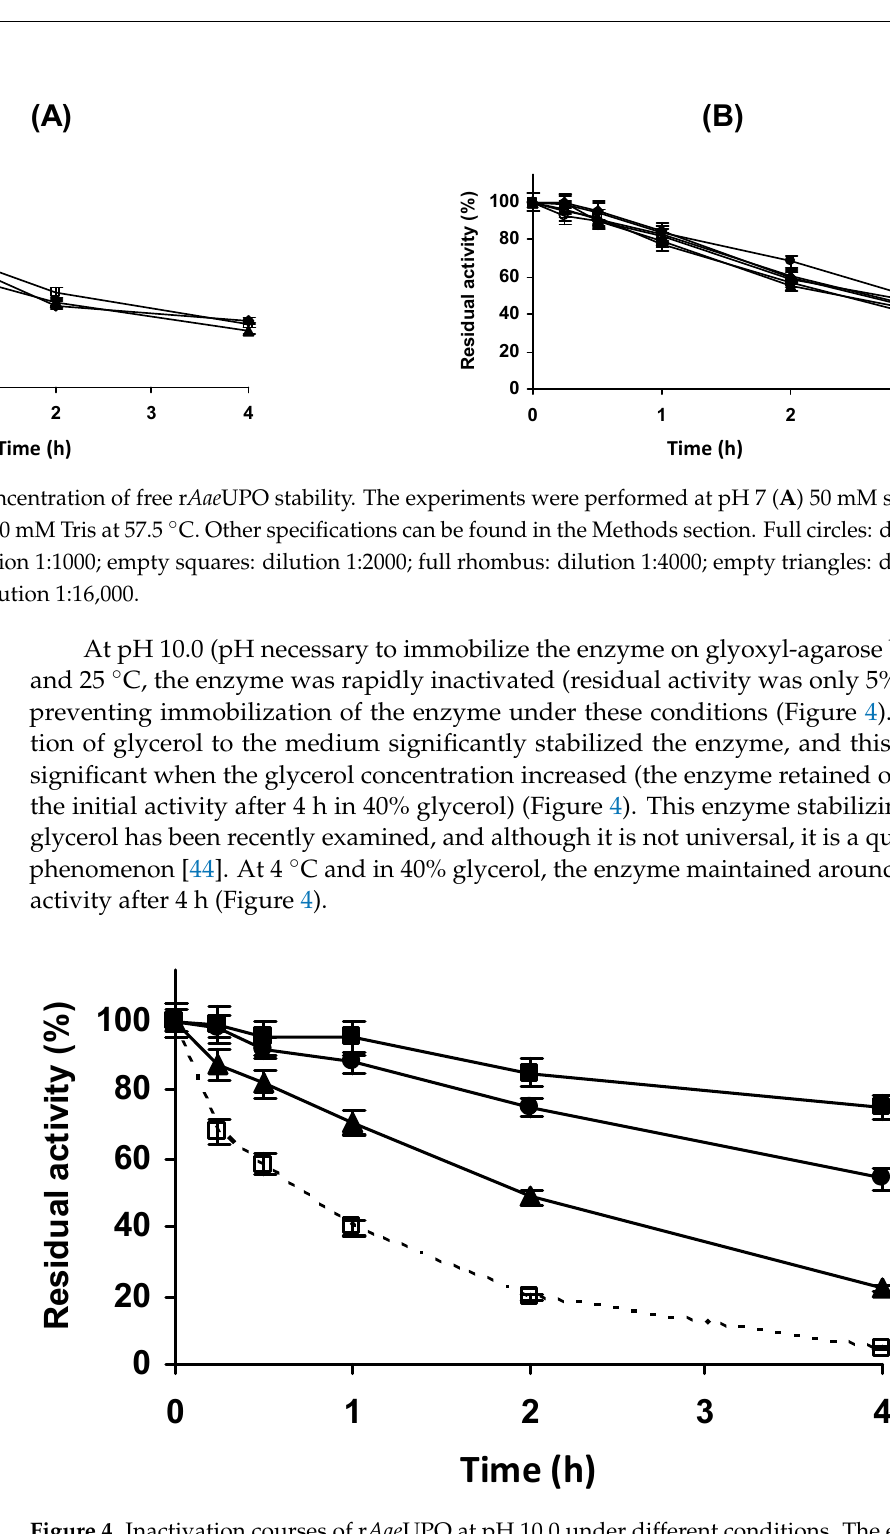
6 of 22 Figure 2. Effect of the buffer nature on the stability of free r Aae UPO. Inactivation was performed at pH 7.0 and ( A ) 50 or ( B ) 57 °C. Other specifications can be found in the Methods section. Full squares: 50 mM HEPES; full circles: 50 mM Tris; full triangles: 50 mM sodium phosphate. This enzyme is dimeric; thus, we investigated whether the enzyme stability depends on the enzyme concentrations in both phosphate and Tris buffers (Figure 3). In both buff- ers, the enzyme concentration did not present a relevant impact on the enzyme stability.